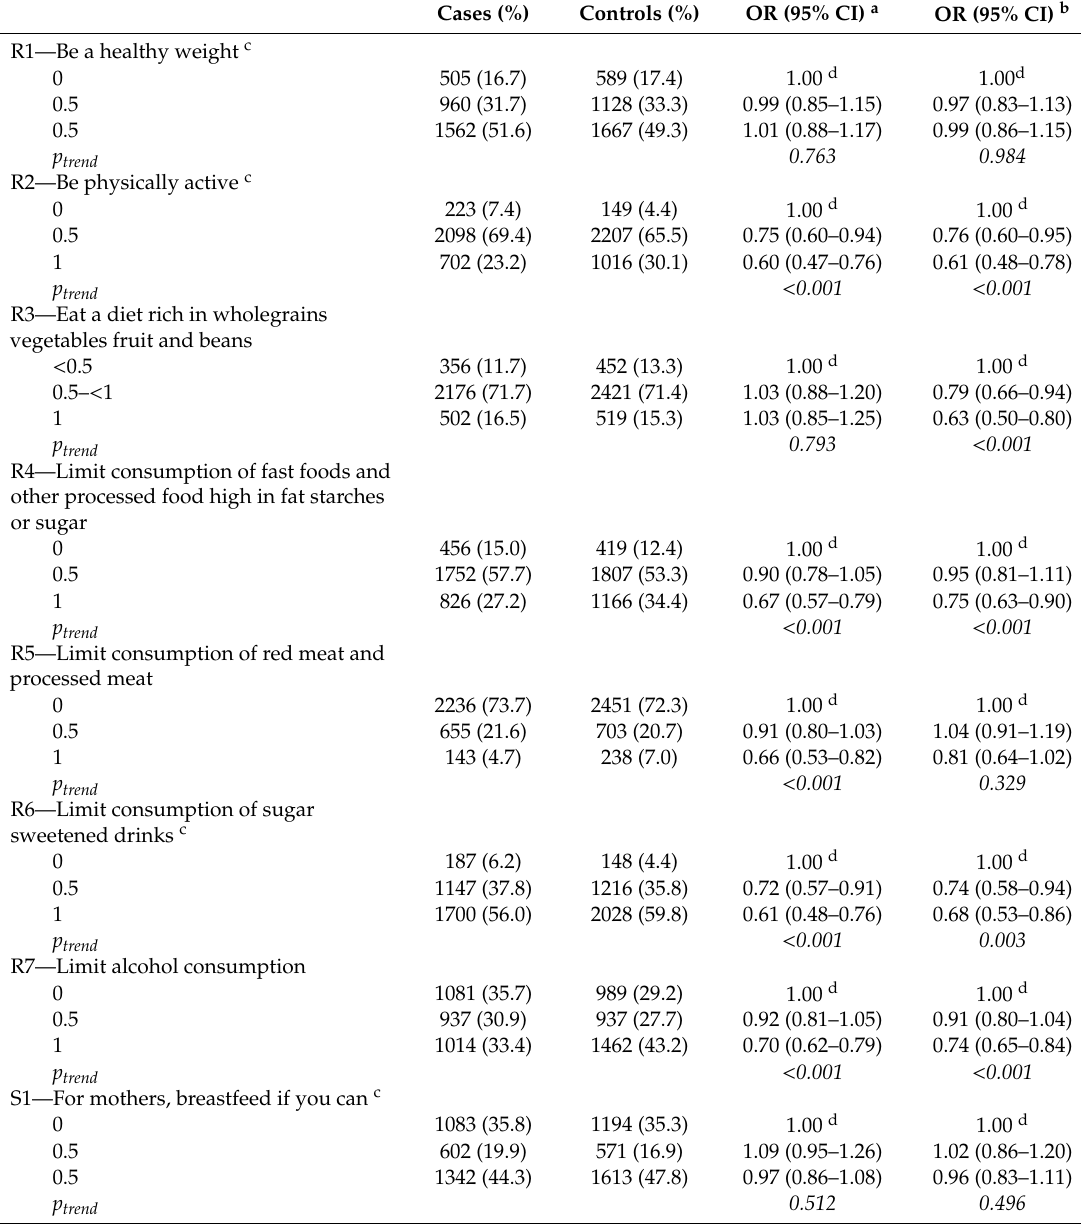
Table 2. Odds ratios (ORs) and corresponding 95% confidence intervals (CIs) of breast cancer for individual 2018 WCRF / AICR recommendations. Italy and Switzerland,